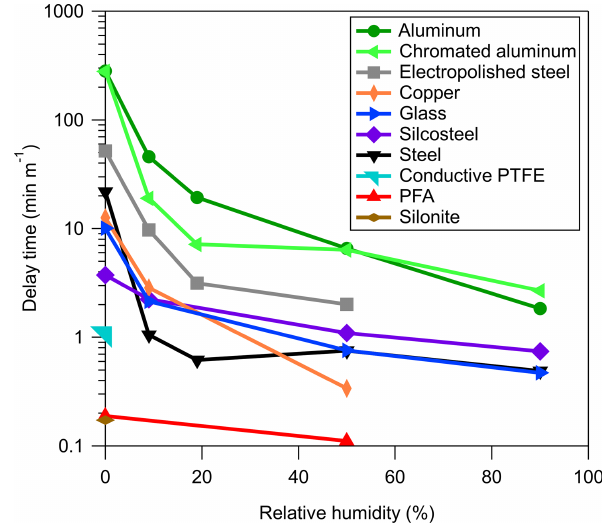
Figure 2. Delay times measured for a series of 2-ketones sampled through tubing composed of different materials. Delay times were normalized to tubing length and saturation concentrations ( C ∗ ) of 2- ketones were estimated at 298K using SIMPOL.1. Error bars were propagated from exponential fits of depassivation curves. Lines are results from the Pagonis et al. (2017) chromatography model.